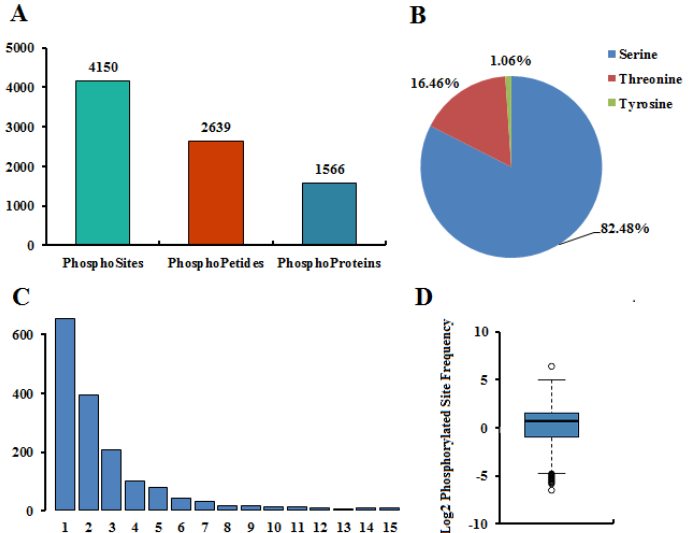
Figure 1. Summary of phosphoproteomic data. ( A ) Statistical results of phosphoproteome identification. ( B ) Distribution of hosphorylation sites. ( C ) The number of hosphorylation sites in